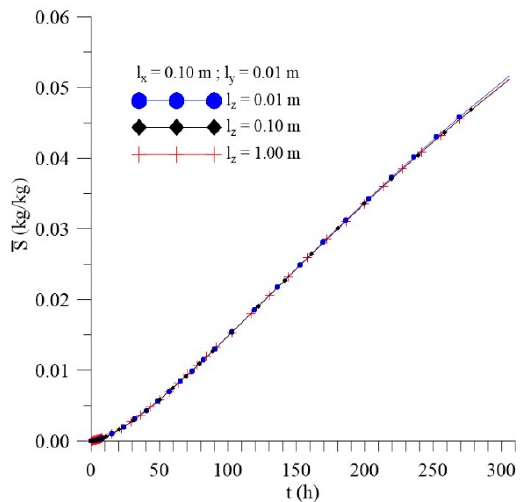
Figure 31. Kinetics of the average entrapped solute concentration for different distances l z (Cases 9, 13, and 14).